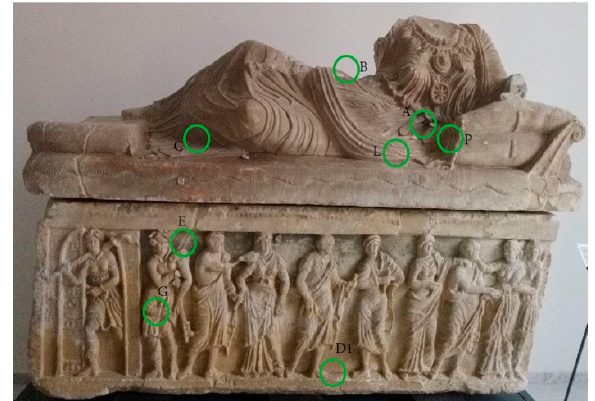
Figure 2. Scalpel sampling points.